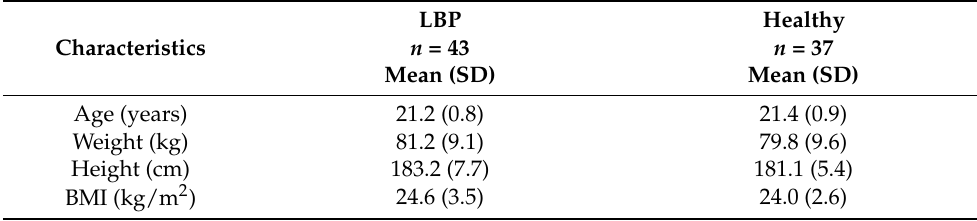
Table 1. Characteristics of study population ( n = 80).